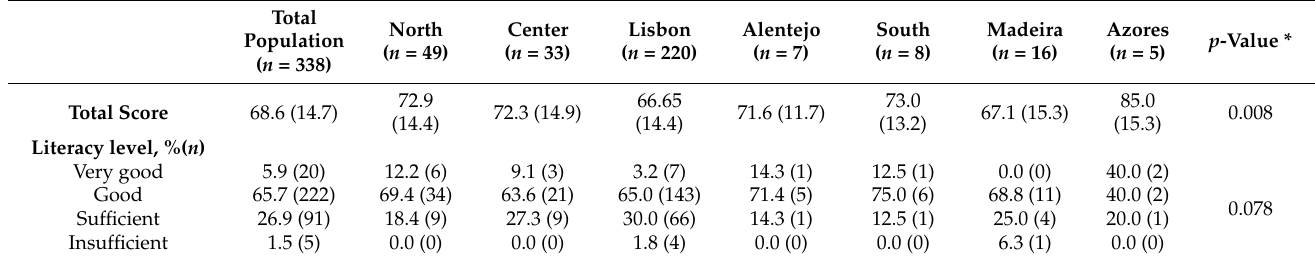
Table 6. The literacy level of the population studied according to a place of living.